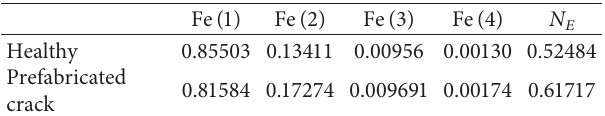
Figure 15: The spectrum of response signal in the harmonic detection. (a) The spectrum of response signal of healthy pillar porcelain insulator. (b) The spectrum of response signal of cracked pillar porcelain insulator. Table 2: Damage detection index value of pillar porcelain insulator under harmonic excitation.